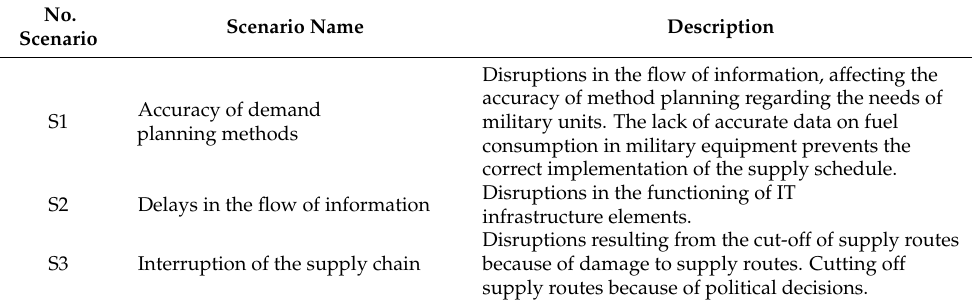
Table 2. Description of the analysed